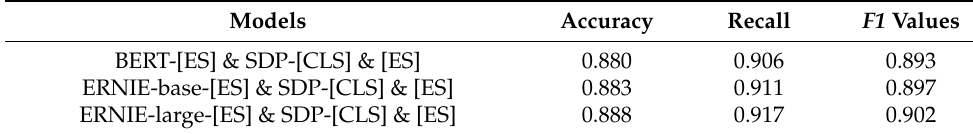
Table 6. The results of different pre-training models.